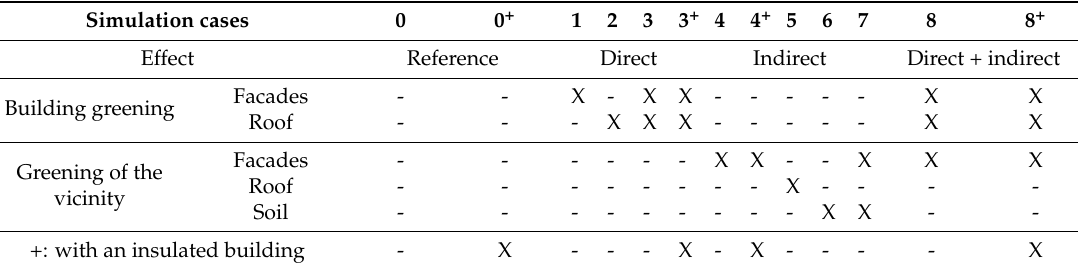
Table 1. The 13 selected simulation